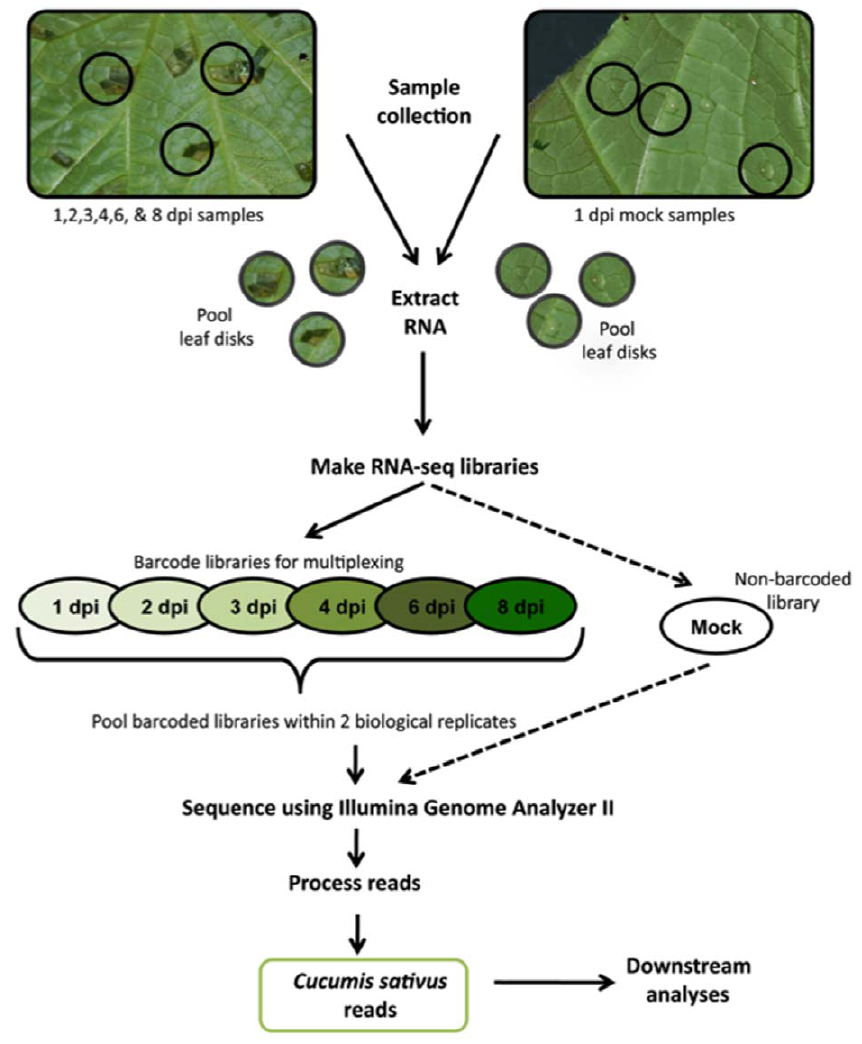
Figure 2. Experimental design and sample collection. Cucumber cv. ‘Vlaspik’ leaves were inoculated on the abaxial leaf surface with 10–30 10 m l droplets of a 1 6 10 5 sporangia/ml solution. Samples were collected at 1, 2, 3, 4, 6, and 8 days post-inoculation (dpi) using a # 3 cork borer to isolate tissue immediately around the infection point (black circles). Samples from cucumber leaves mock-inoculated with 10 m l droplets of dH 2 O were collected in the same manner at 1 dpi. Leaf disks from each time point were pooled for RNA extraction. mRNA-Seq libraries were made for each time point from two separate biological replicates. Within a biological replicate, libraries were barcoded and sequenced in multiple lanes with the exception of the mock-inoculated library, which was not barcoded.